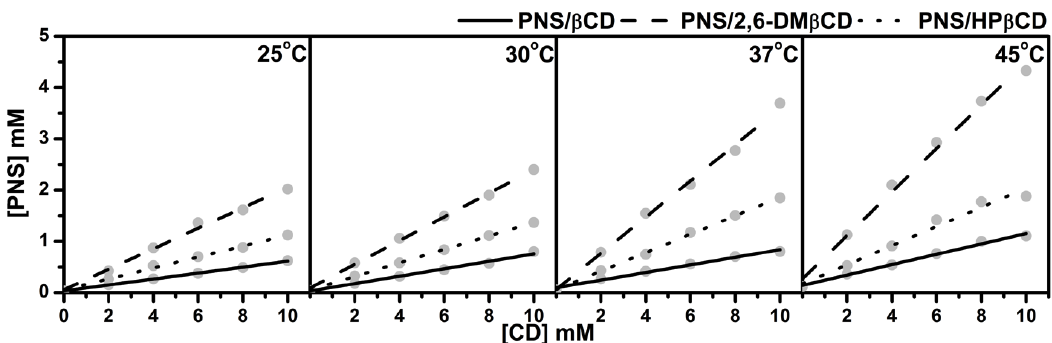
Figure 2. Phase solubility diagram for PNS with various concentrations of (—) βCD, (­­­) 2,6-DMβCD and (···) HPβCD at different temperatures.